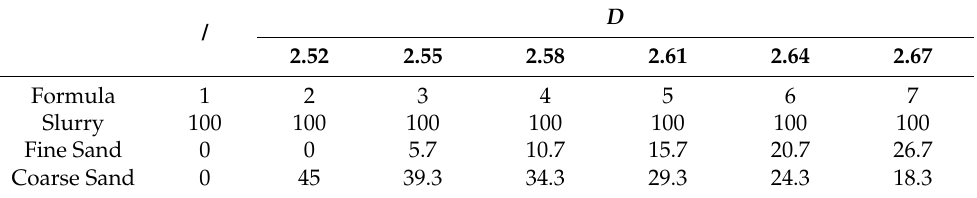
Table 3. Three component mass fractions by different fractal dimensions (sand amount